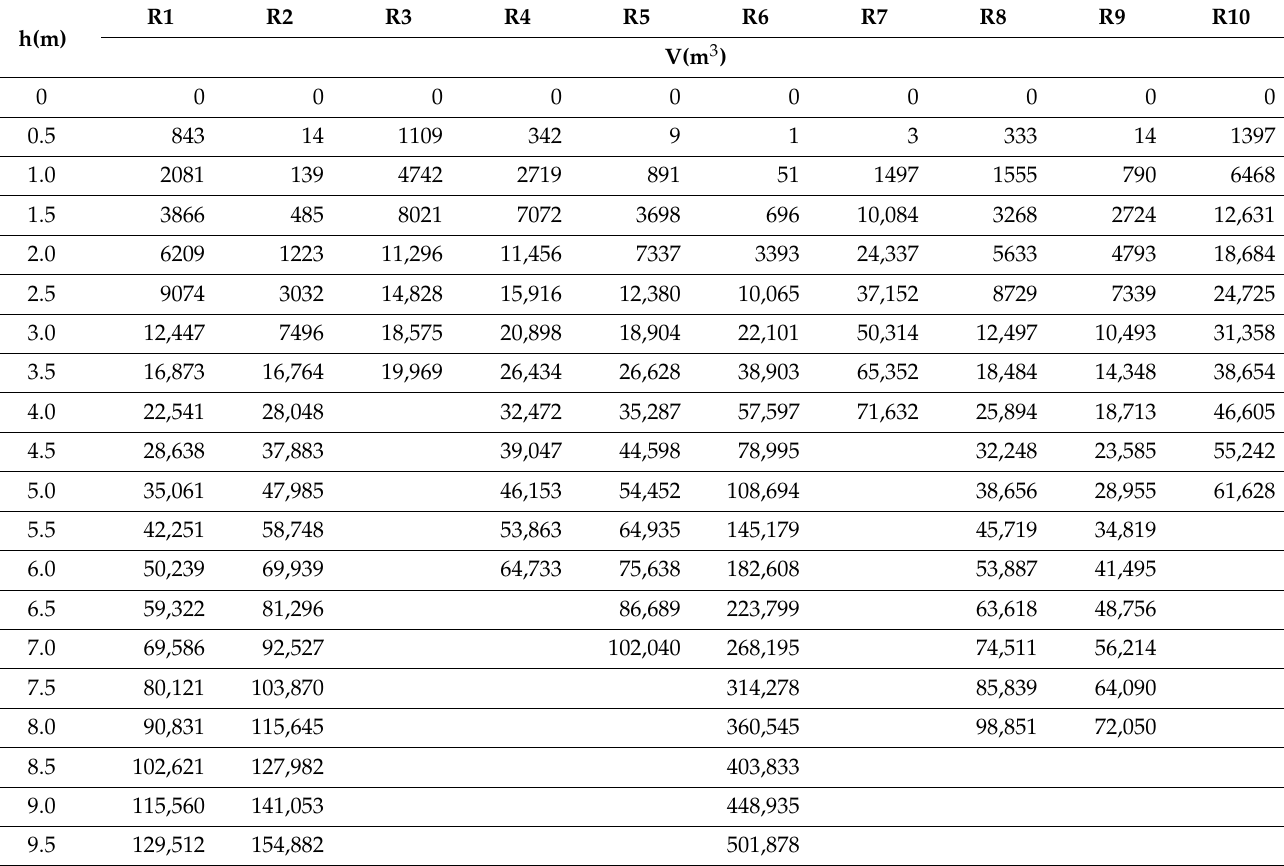
Table 3. Volume measurements according to the change in reservoir